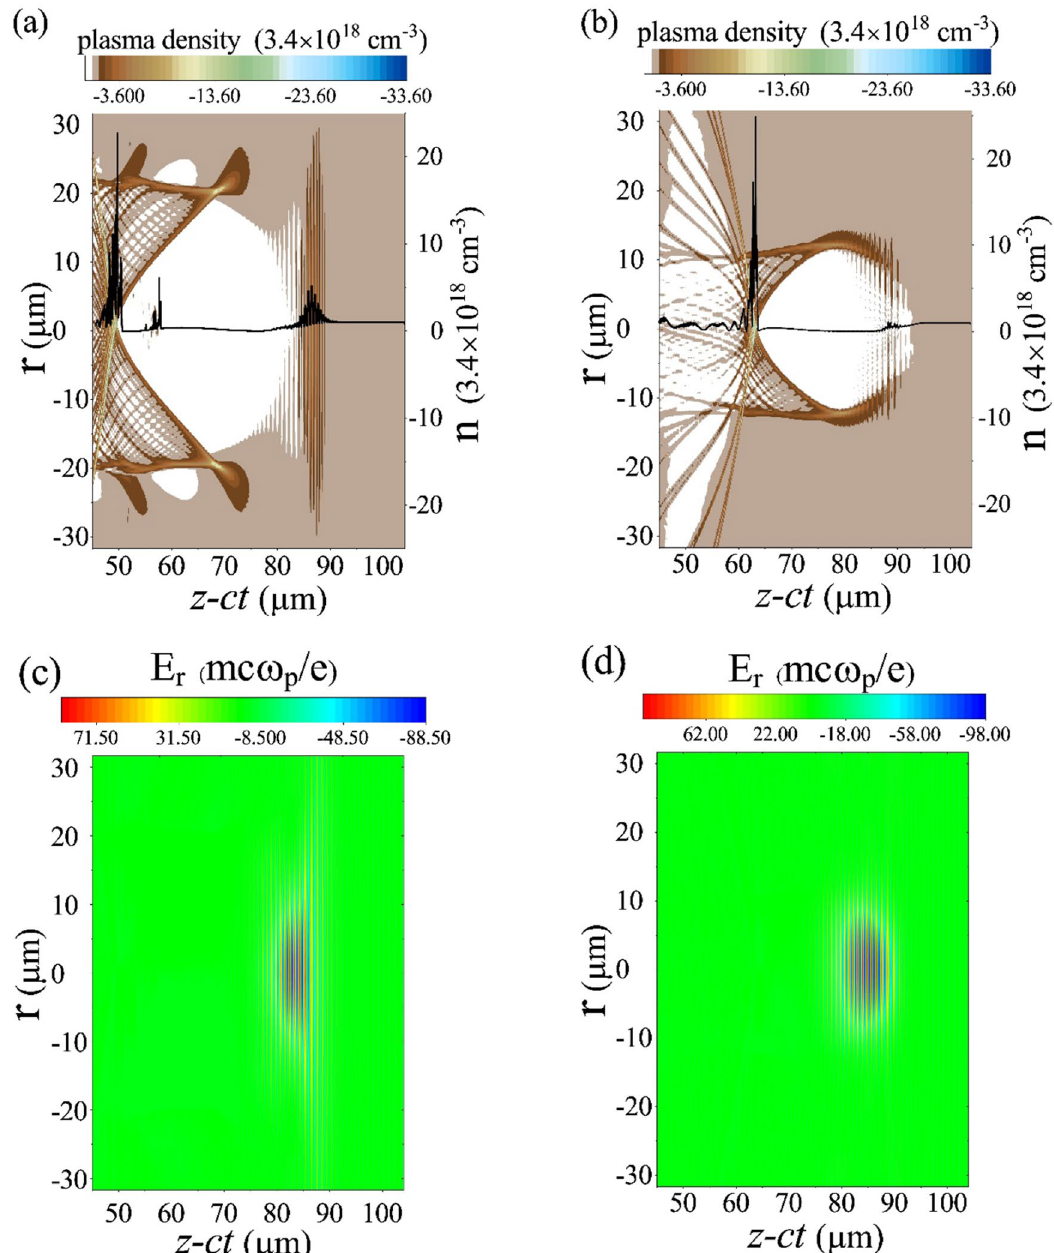
Figure 5. Effects of initial electron beam position on electron self-injection and laser self-guiding at 2.3 mm propagation distance. ( a ) Plasma electron density snapshot and density distribution on the propagation axis (black line). The electron beam is initially located 3 μm behind the laser pulse peak. ( b ) Plasma electron density snapshot and density distribution on the propagation axis (black line). The electron beam is initially located 5.8 μm ahead of the laser pulse peak. ( c ) Transverse laser pulse profile. The electron beam is initially located 3 μm behind the laser pulse peak. ( d ) Transverse laser pulse profile. The electron beam is initially located 5.8 μm ahead of the laser pulse